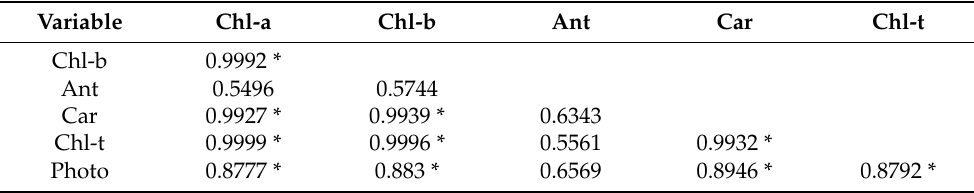
Table 1. Pearson correlations among the leaf pigments and photosynthetic rate of kaffir lime.